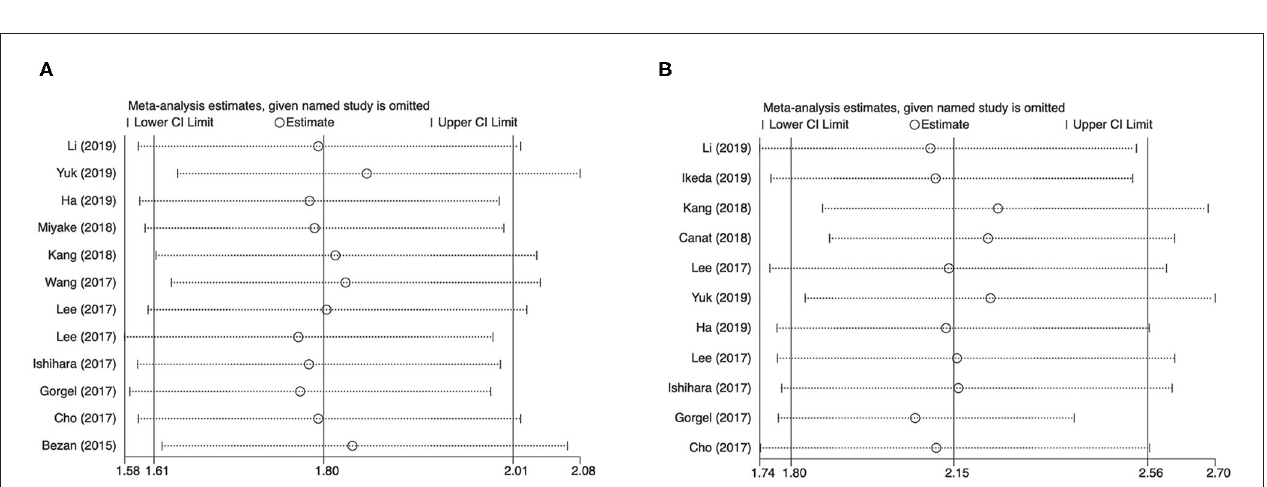
FIGURE 5 | Results of sensitivity analysis. (A) correlation of De Ritis ratio with OS in urological cancers; (B) correlation of De Ritis ratio with CSS in urological cancers.